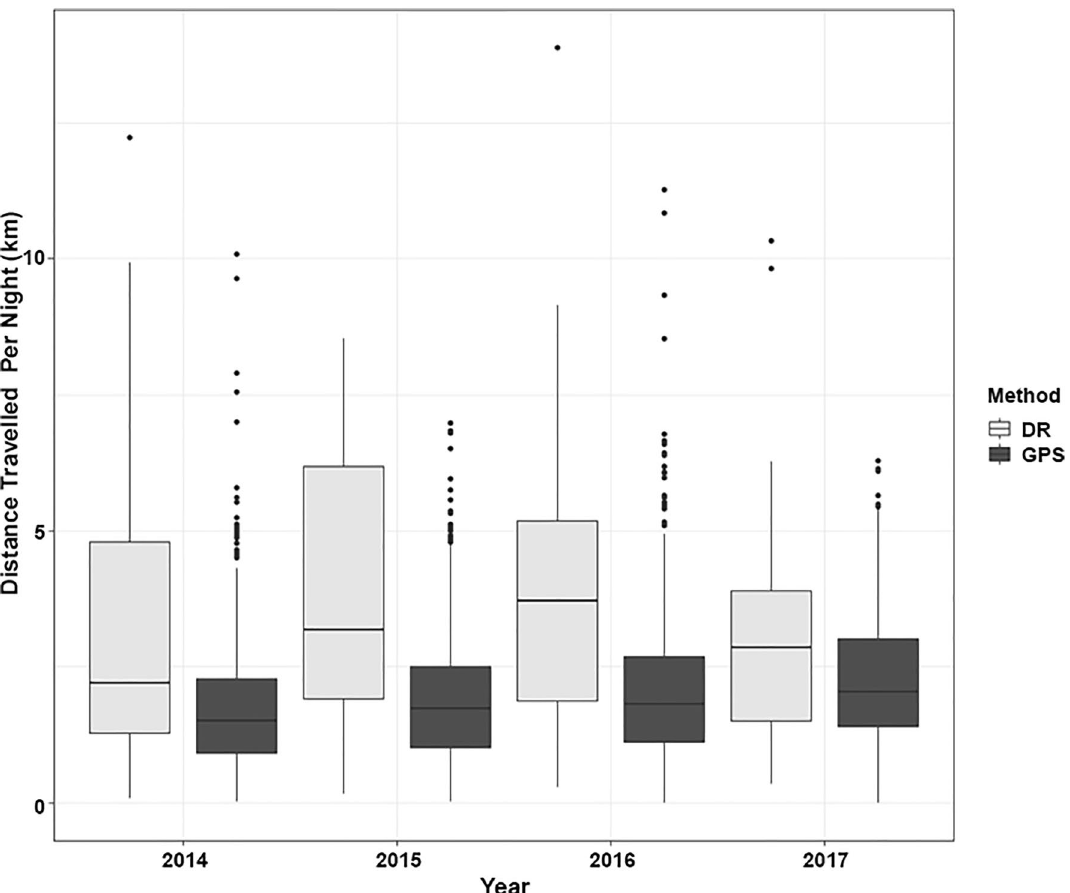
Figure 8. Mean distance travelled per night (km) as calculated using just the GPS data (‘GPS’), dark bars, or the GPS-enhanced dead-reckoned data (‘DR’), light bars, as a function of year (2014–2017). The median is shown as a black horizontal line, with upper and lower quartiles (mean point between maximum/minimum data points and the median) at the top/bottom of the bar. Whiskers (vertical black lines) denote lower and upper 25% of data values. Black points denote outliers (data points 1.5 times lower/higher than the interquartile